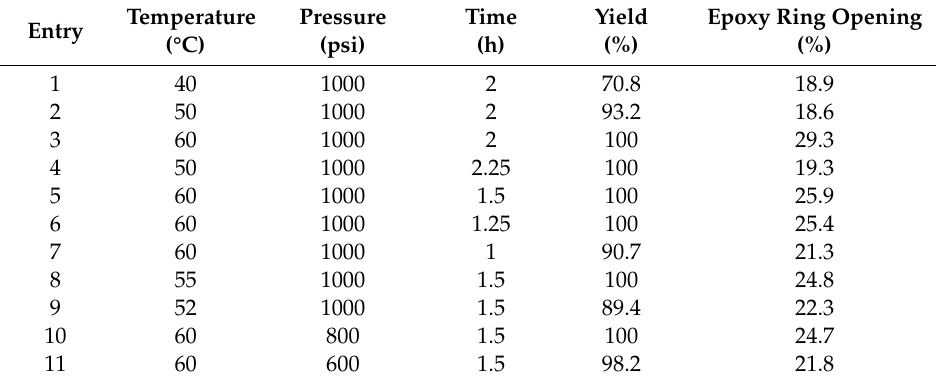
Table 2. Hydrogenation of BE503 using Rh 5 / VulcanXC72-polyol at di ff erent reaction